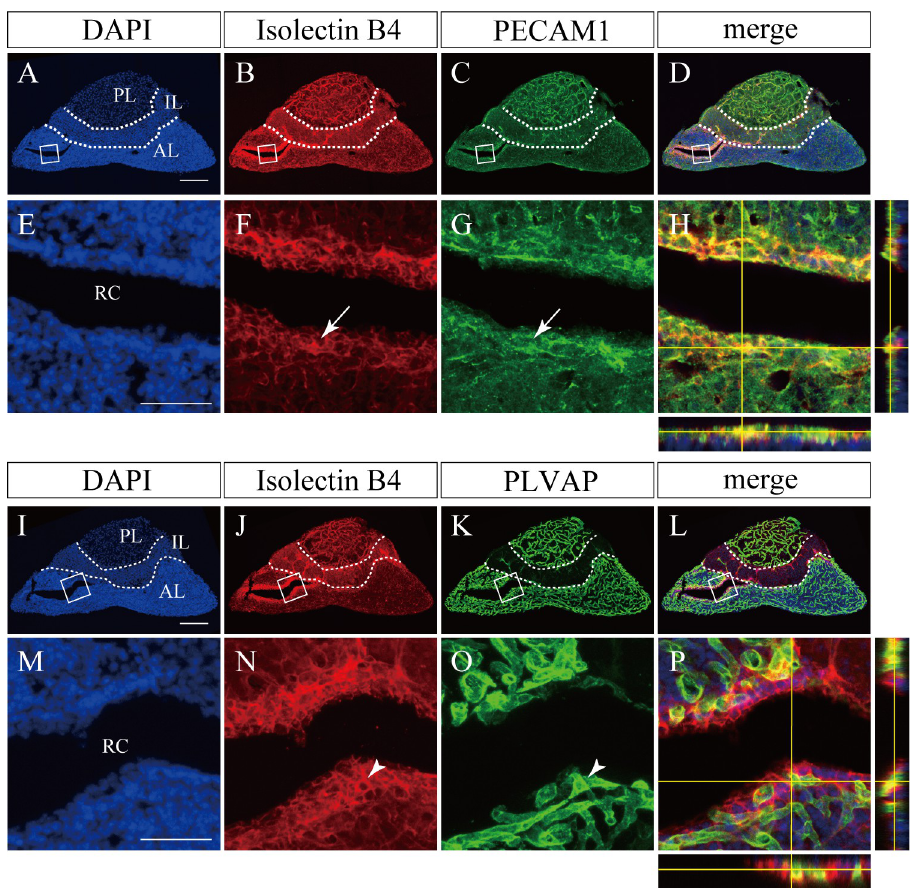
Fig 3. Comparison of isolectin B4 staining with PECAM1 and PLVAP immunostaining. Representative confocal immunofluorescence sagittal images with orthogonal views. Boxed regions in A-D and I-L are enlarged in E-H and M-P, respectively. Arrows and arrow heads indicate the intersection points of the XZ and YZ planes. (A-H) The pattern of isolectin B4 staining (red) was extremely similar to that of PECAM1 immunostaining (green), including the surrounding area of Rathke’s cleft. (I-P) A significant number of cells positive for isolectin B4 staining were positive for PLVAP. Bars, 200 μ m. AL, anterior lobe; IL, intermediate lobe; PL, posterior lobe.